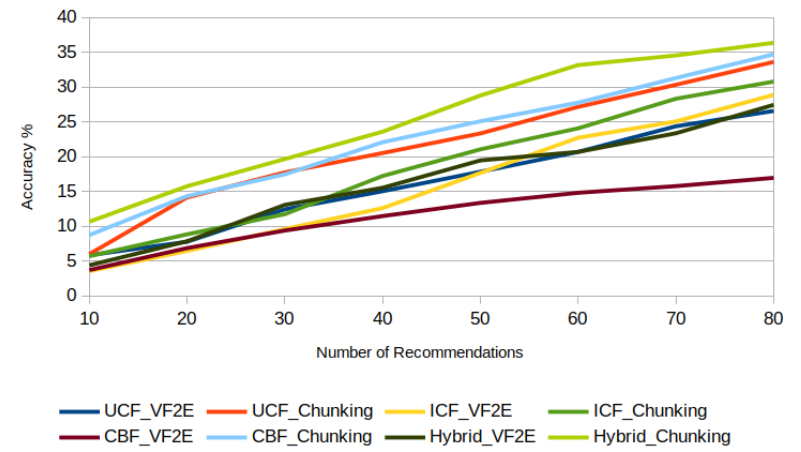
Figure 12. Comparison among our proposed techniques (Chunking) with baseline methods (VF2E) on average results of three groups (combined). The blue, red, yellow, and green lines show performance score of the recommendation techniques UCF, ICF, CBF, and Hybrid,